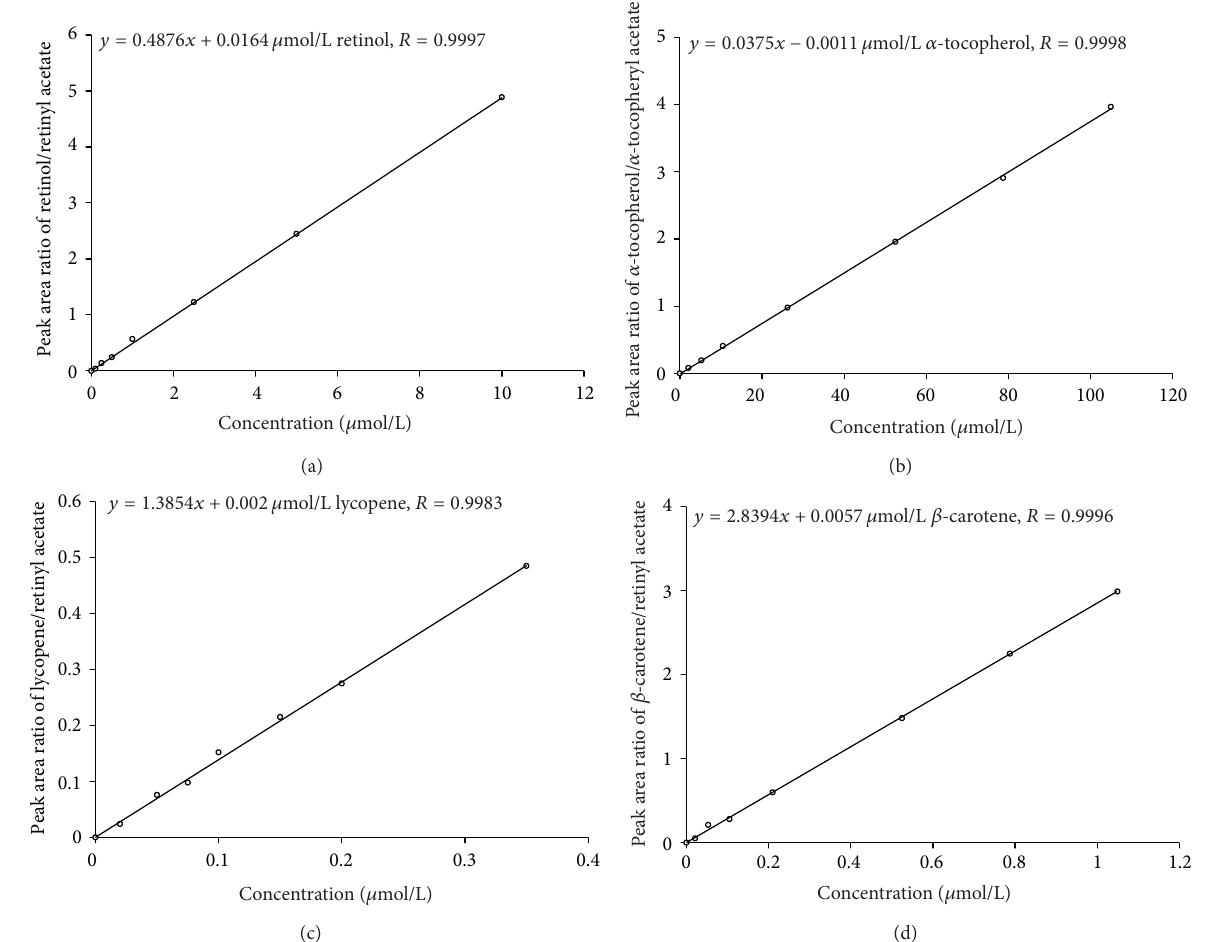
F 4: Typical calibration curves for HPLC quanti�cation of retinol (a),